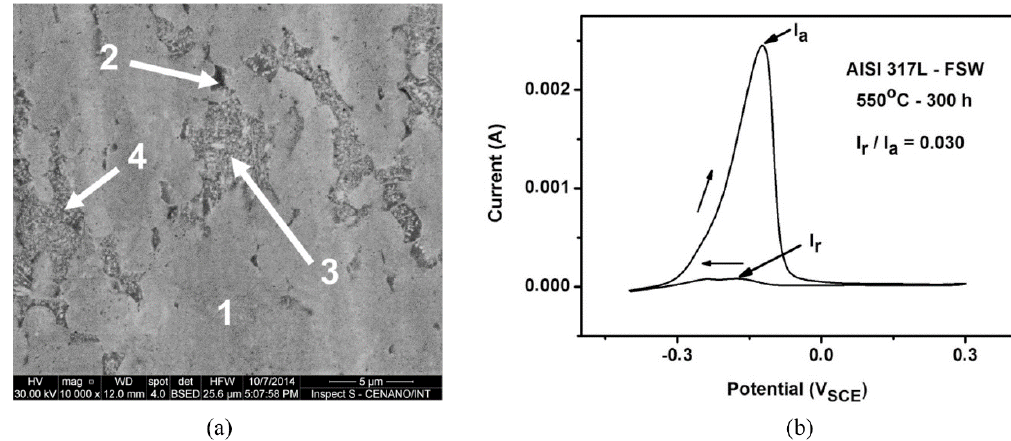
Figure 4. (a) Microstructure and (b) DL-EPR curve of specimen aged at 550 °C for 300 h.